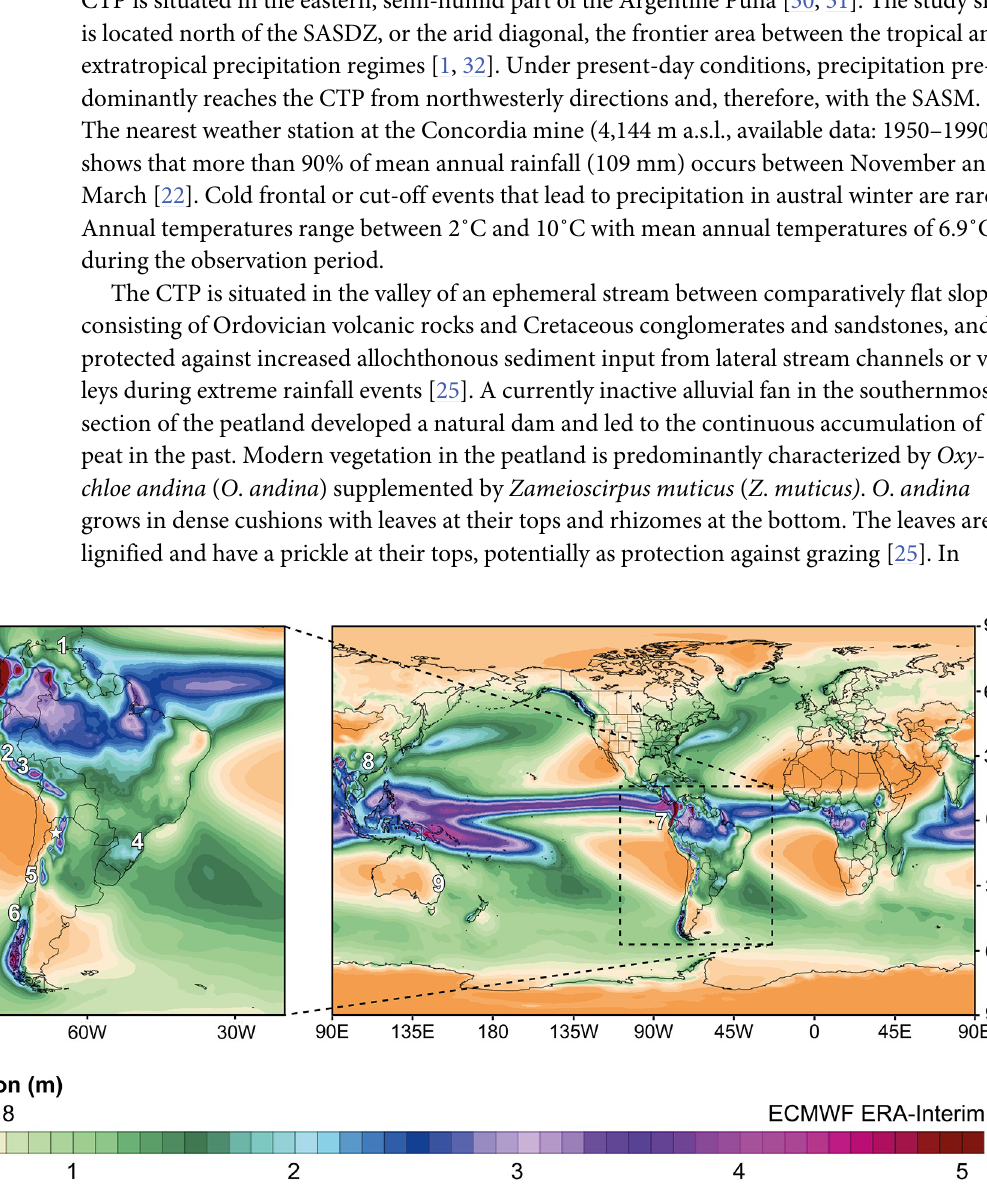
PLOS ONE | https://doi.org/10.1371/journal.pone.0277027 November10,